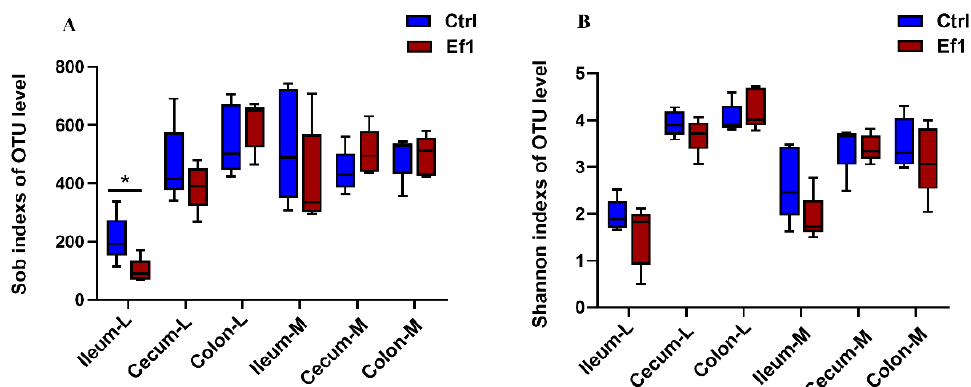
Figure 1. Alpha diversity of gut microbiota in the luminal contents and the corresponding mucosal tis- sues of ileum, cecum, and colon. ( A ) Sobs index, ( B ) Shannon index. L, luminal contents; M, mucosa; Ctrl, control; Ef1, Enterococcus faecium HDRsEf1; n = 5 per group. Values are median ± interquartile range, * p < 0.05.